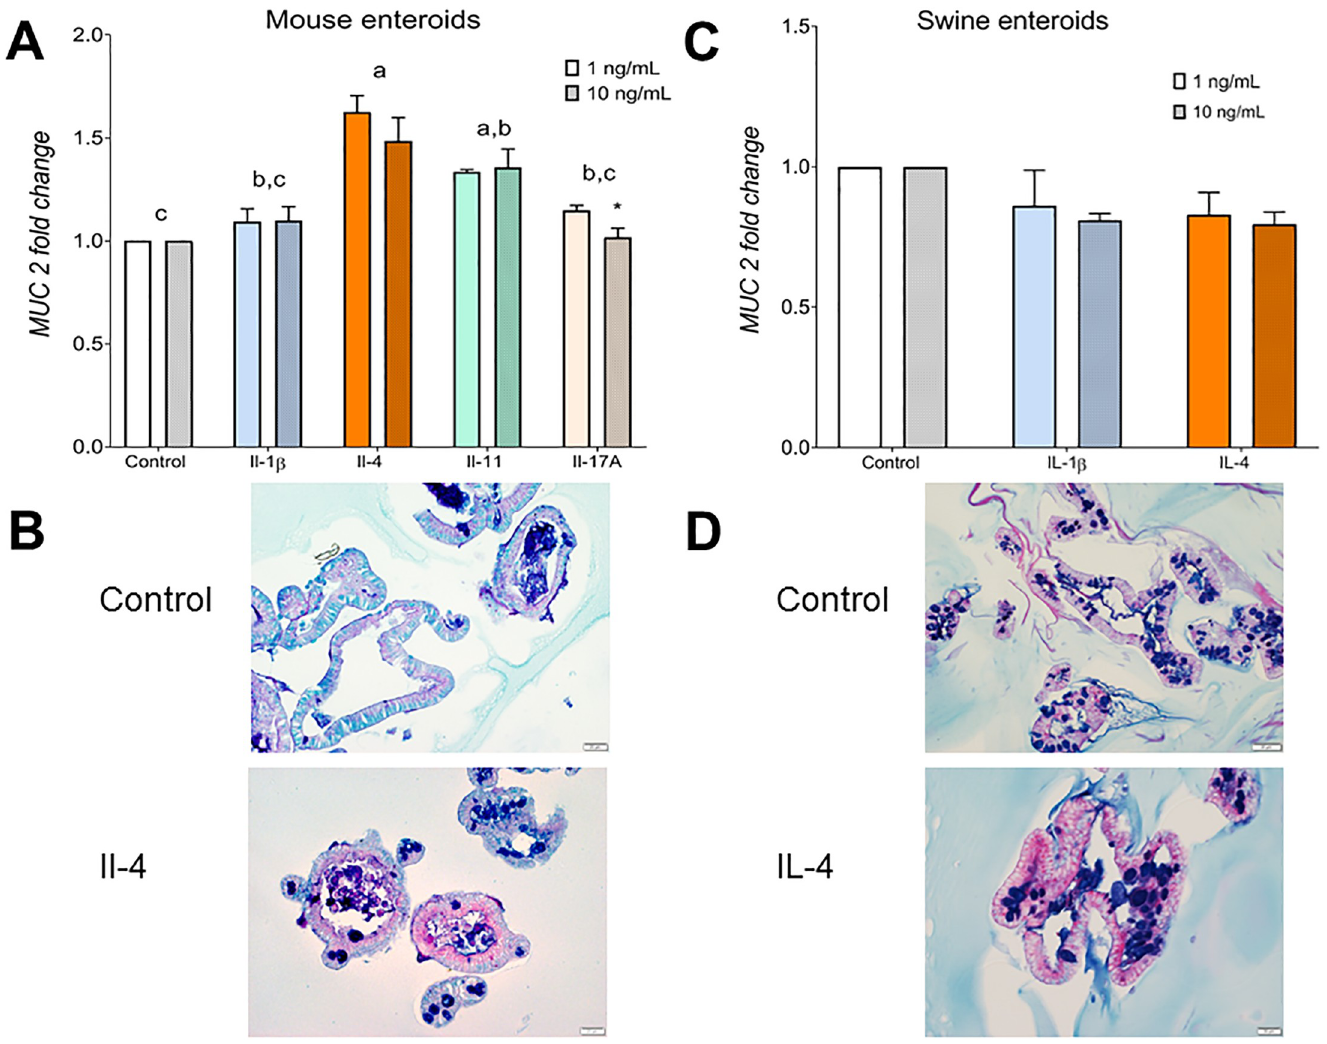
Fig 2. Mucin 2 gene expression (A) and presence of goblet cells shown by staining with periodic acid-Schiff with Alcian blue (B) of mouse and swine enteroids (C and D) treated with different interleukins at 1 and 10 ng/mL concentration for 24 h. N = 3 independent experiments. Data are presented as mean ± standard error of the mean, normalized to the respective experimental control. Dietary treatment groups with different superscripts are different ( P > 0.05). Asterisk ( � ) indicates different to Il-4 when treated with 10 ng/mL of Il-17A.